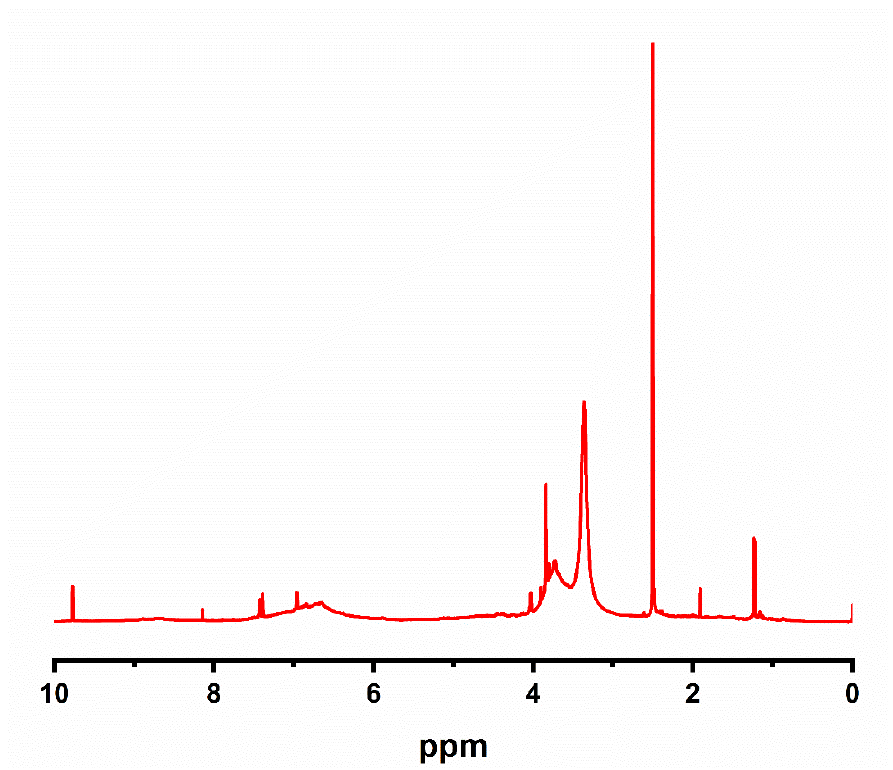
Figure 3. H NMR spectrometry of the sample of lignin .